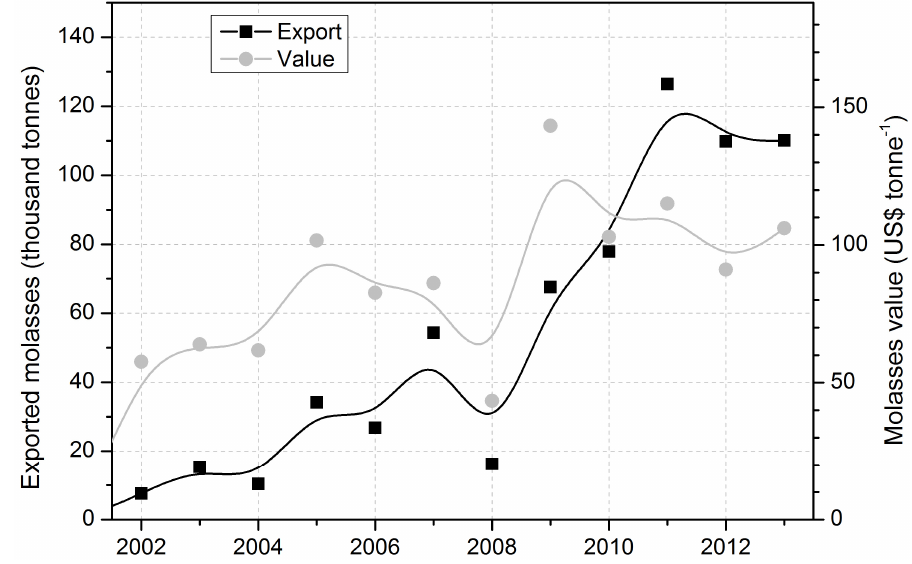
Figure 3. Exported quantity and market value for molasses in Mozambique form 2002 to 2013. Source: [17]. Assuming molasses at US$ 100 per ton, a reference value for the period between 2009 and 2013 (Figure 3), and pump gasoline prices in Mozambique (i.e., US$ 0.98 per liter (http://pt.globalpetrolprices.com/Mozambique/gasoline_prices/) in May 2016) the economic